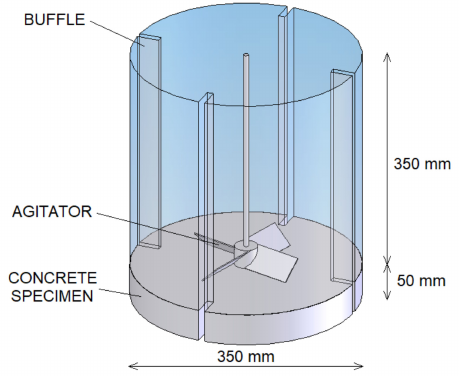
Figure 2. Experimental setup.